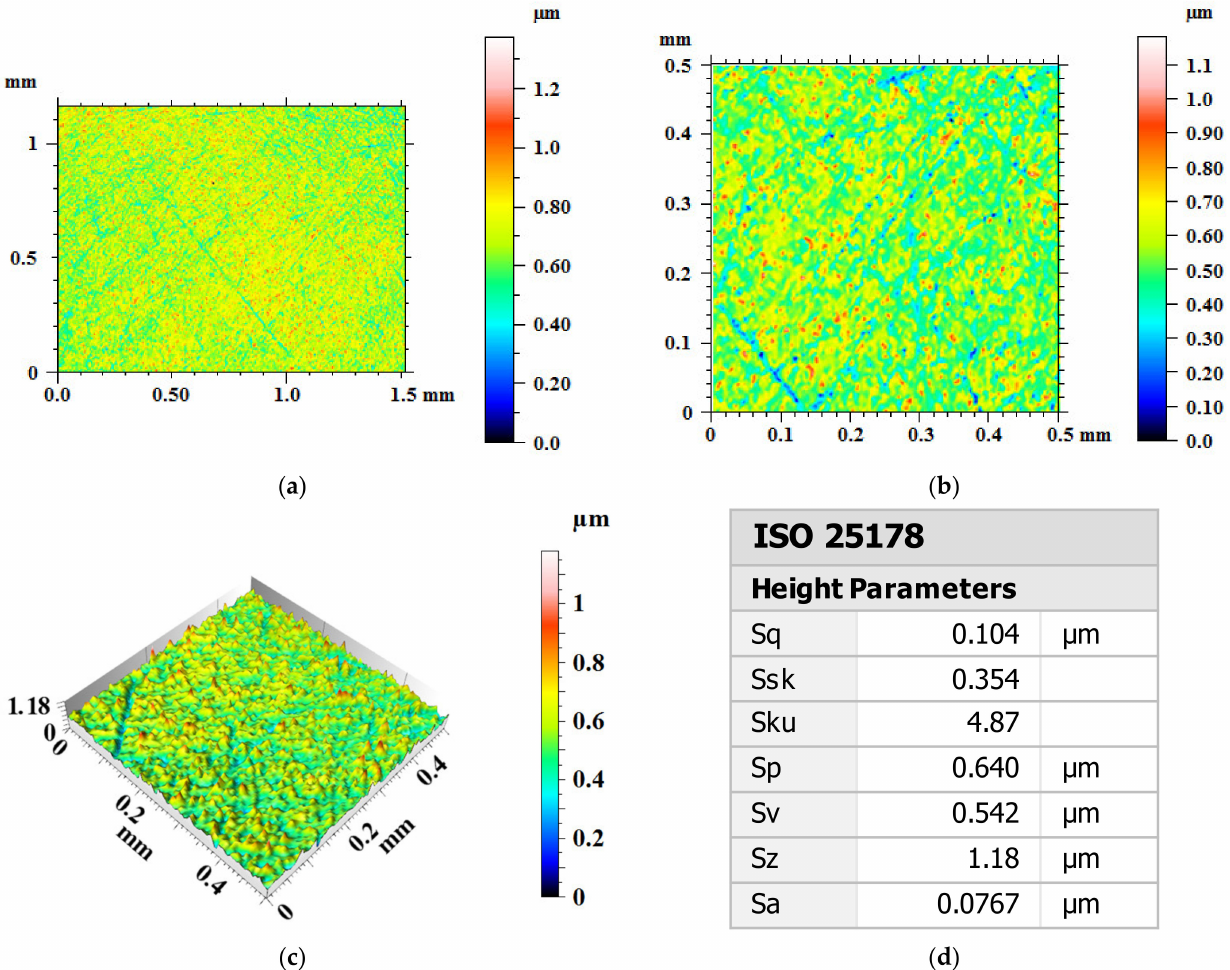
Figure 7. Surface morphology and roughness of Ti-6Al-4V workpiece before polishing. ( a ) Two-dimensional surface topography with measuring area of 1.5 mm × 1.15 mm; ( b ) two-dimensional surface topography with measuring area of 0.5 mm × 0.5 mm; ( c ) three-dimensional surface topography with measuring area of 0.5 mm × 0.5 mm ( d ) surface roughness